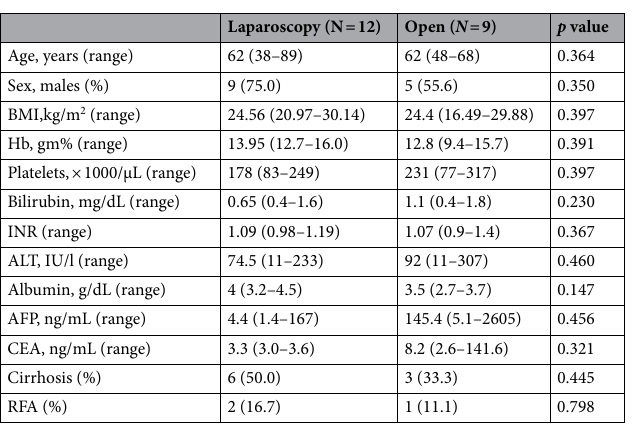
Table 1. Baseline characteristics. BMI body mass index, Hb hemoglobin, INR international normalized ratio, ALT alanine aminotransferase, AFP α-fetoprotein, CEA carcinoembryonic antigen, RFA radiofrequency